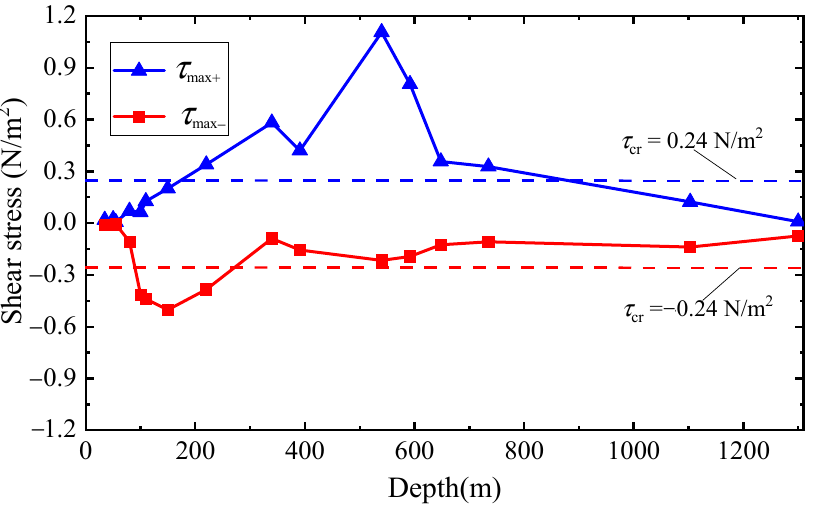
Figure 11. Relationship between maximum shear stress and water depth.